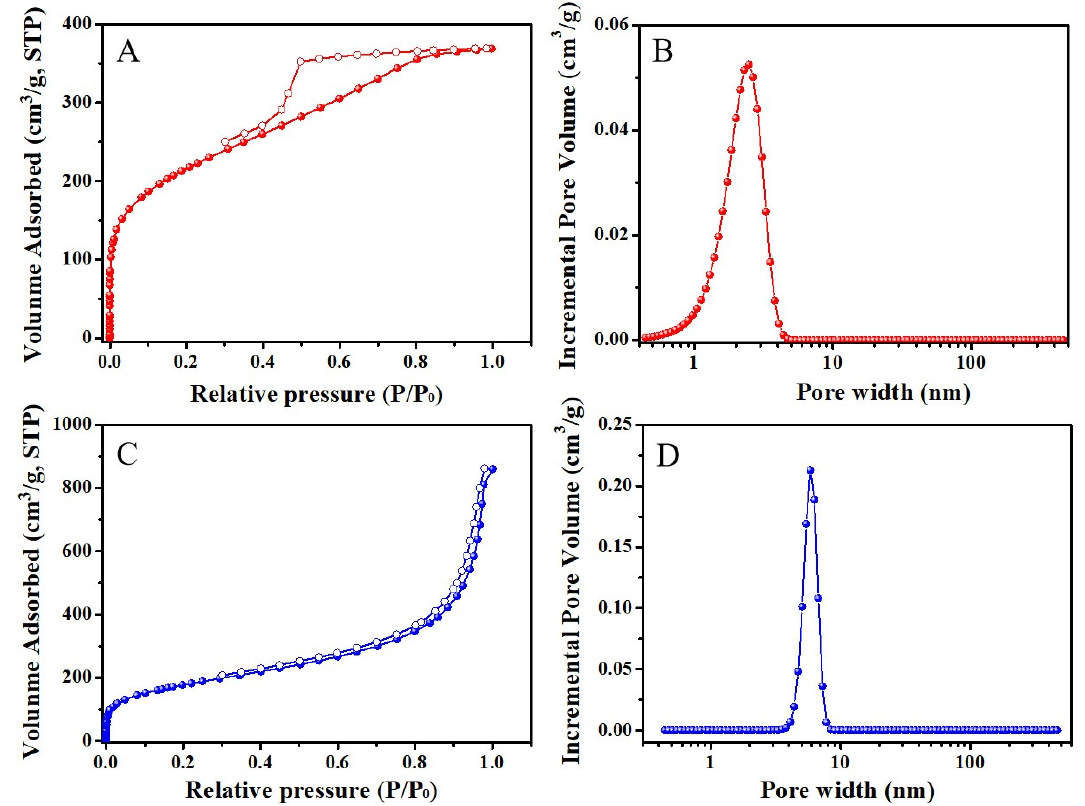
Figure 2. ( A – C ) N 2 sorption isotherm and ( B – D ) pore size distribution of POP-PBC and POP-PBH. Figure 2. ( A , C ) N 2 sorption isotherm and ( B , D ) pore size distribution of POP-PBC and